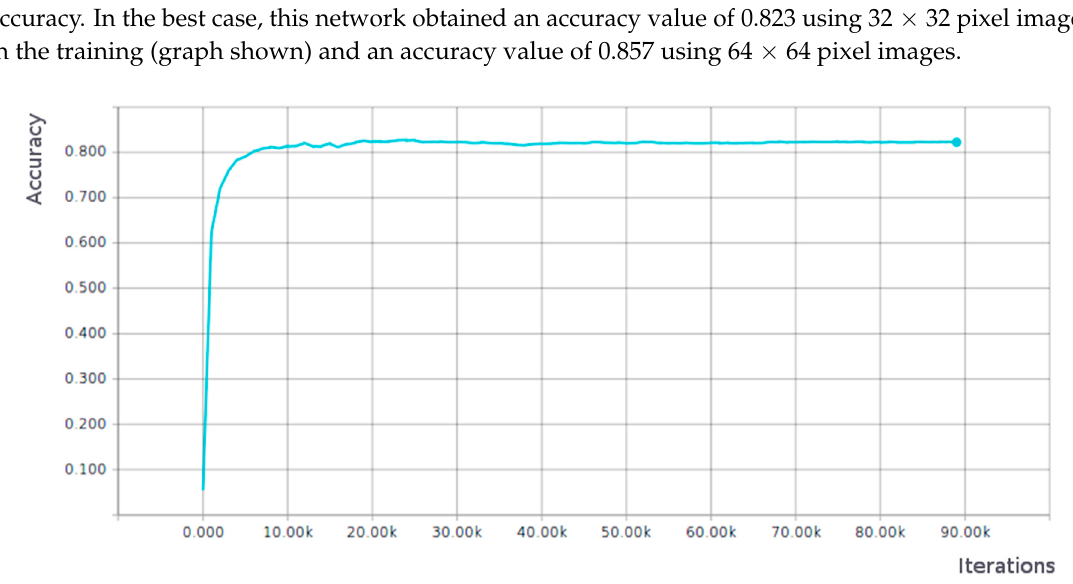
Figure 2. Accuracy results of the AlexNet network using validation images.